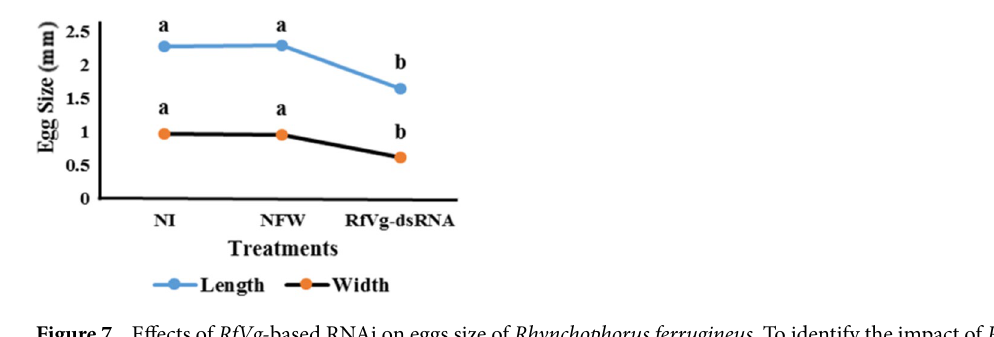
Figure 7. Effects of RfVg -based RNAi on eggs size of Rhynchophorus ferrugineus . To identify the impact of RfVg based RNAi on egg size, 15 eggs from each group (NI, NFW, and RfVg -dsRNA) were measured by using Dino- Lite Digital Microscope AM4815ZT (AnMo Electronic Corp, USA). To test the statistical significance among different biological parameters a one-way analysis of variance was performed at (α = 0.05). Different letters (a,b) above the bars show significant difference among the treatment